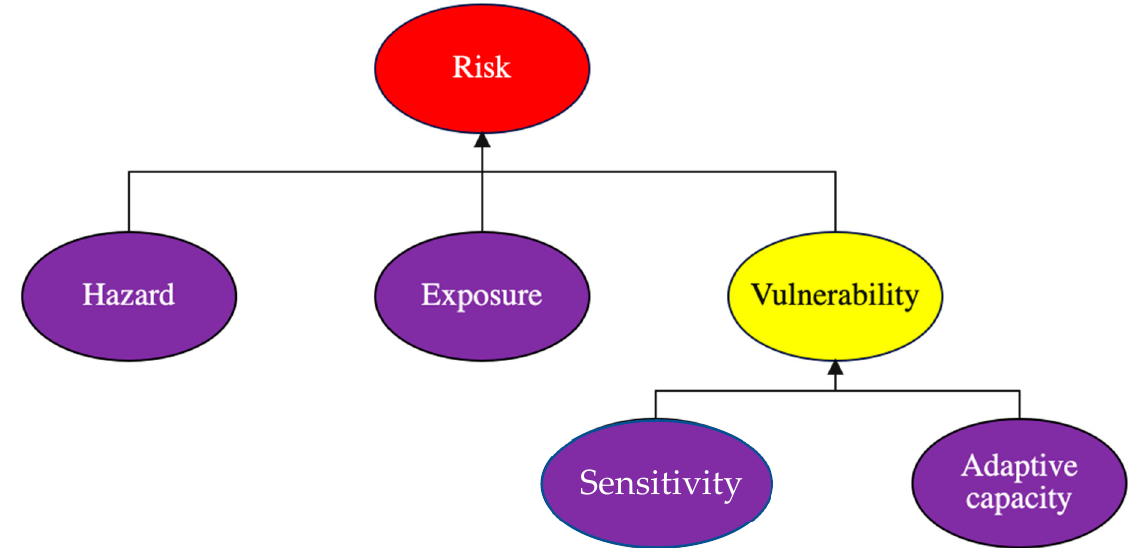
Figure 1. The IPCC’s risk assessment framework [9].